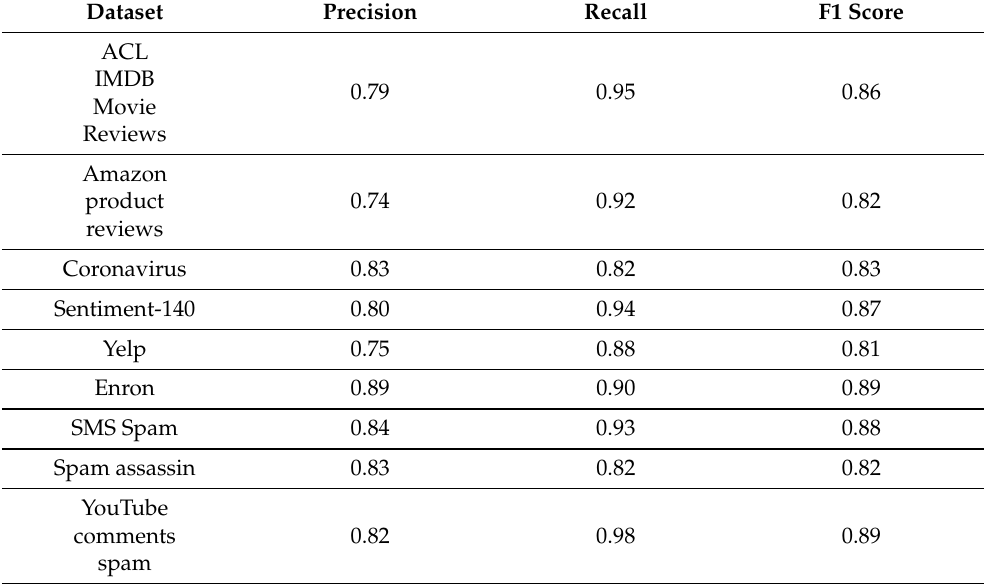
Table 5. The precision, recall and F1 score values of the SPHH when applied to the text process- ing